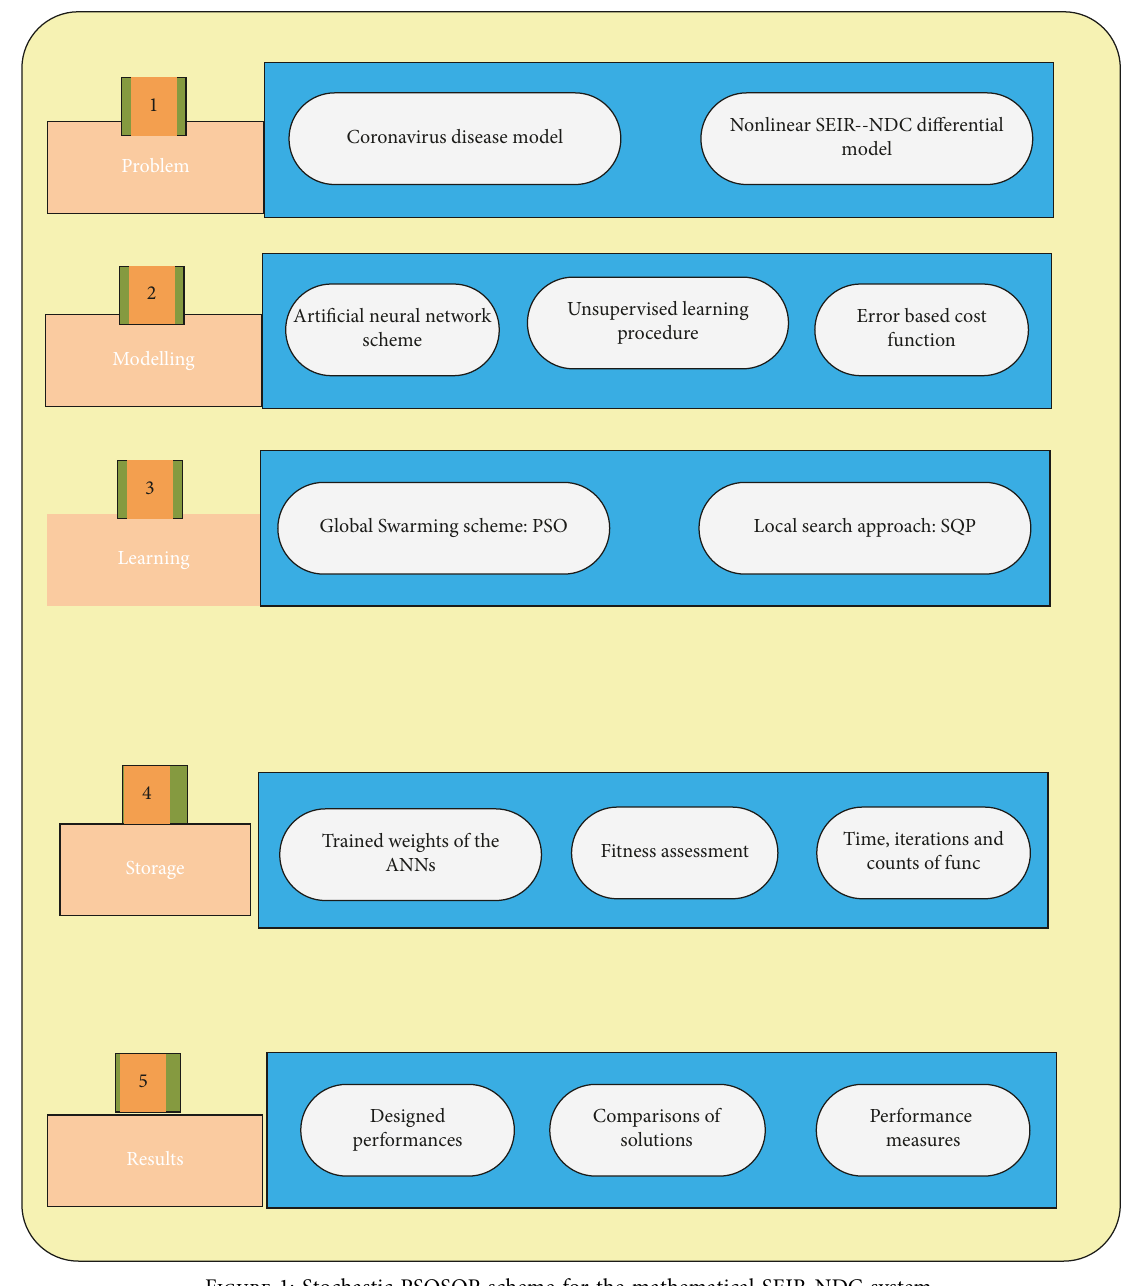
Figure 1: Stochastic PSOSQP scheme for the mathematical SEIR-NDC